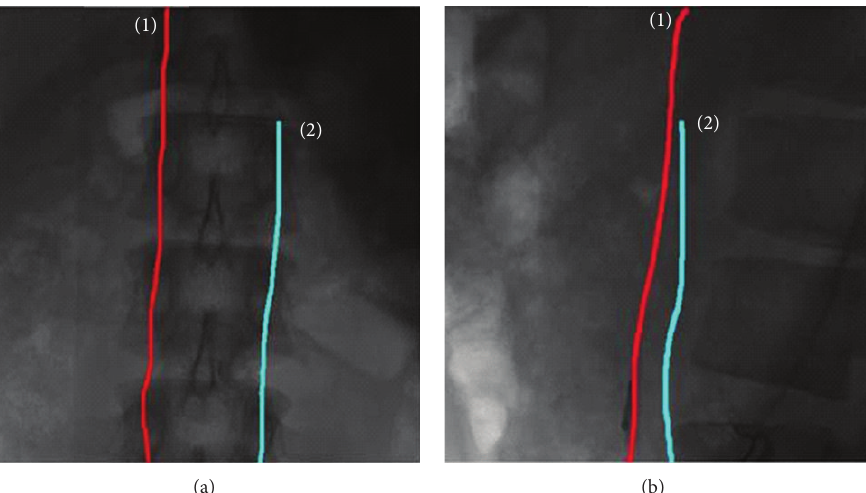
Figure 1: Double interventional cardiac catheterization (ICC): (a) frontal image, (b) lateral image. Note: (1) Berman catheter, (2) pigtail